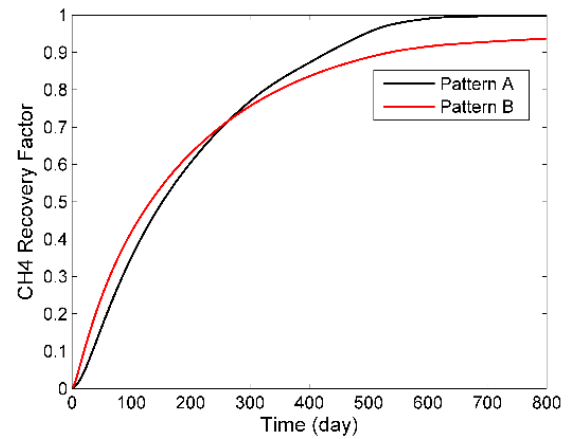
Figure 27. Comparison of methane recovery factor.